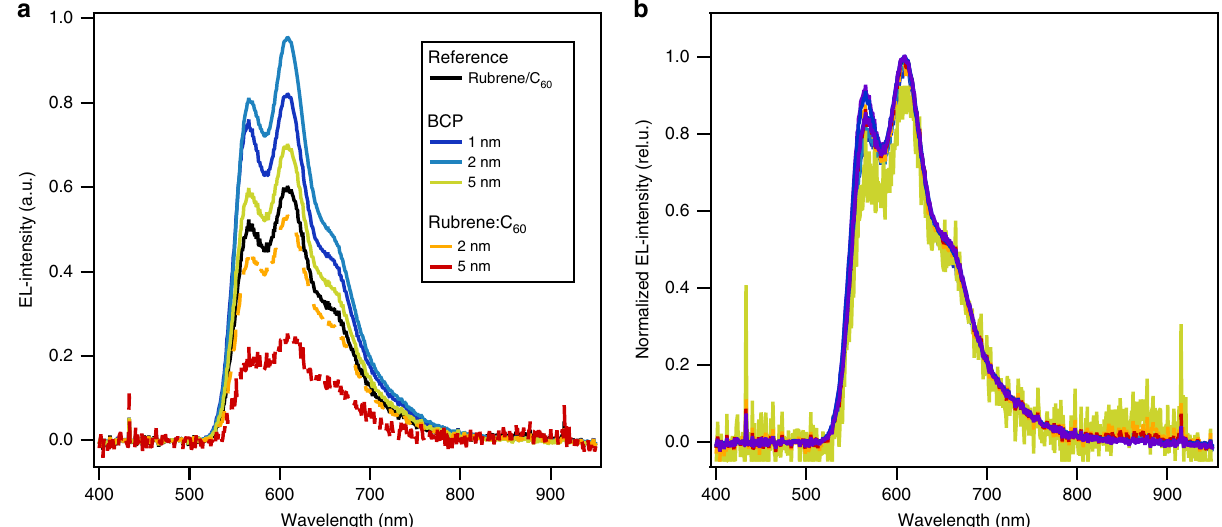
Fig. 3 Emission spectra. a Electroluminescence spectra of rubrene/C 60 OLEDs with BCP or rubrene:C60 (1:1) interlayers inserted between the rubrene and C 60 layers. For comparison, a control device (rubrene/C 60 ) with no interlayer is shown. b The emission data normalized to the maximum (in the wavelength range 600 – 610 nm). All spectra were recorded at a current level of 18.75 mA/cm 2